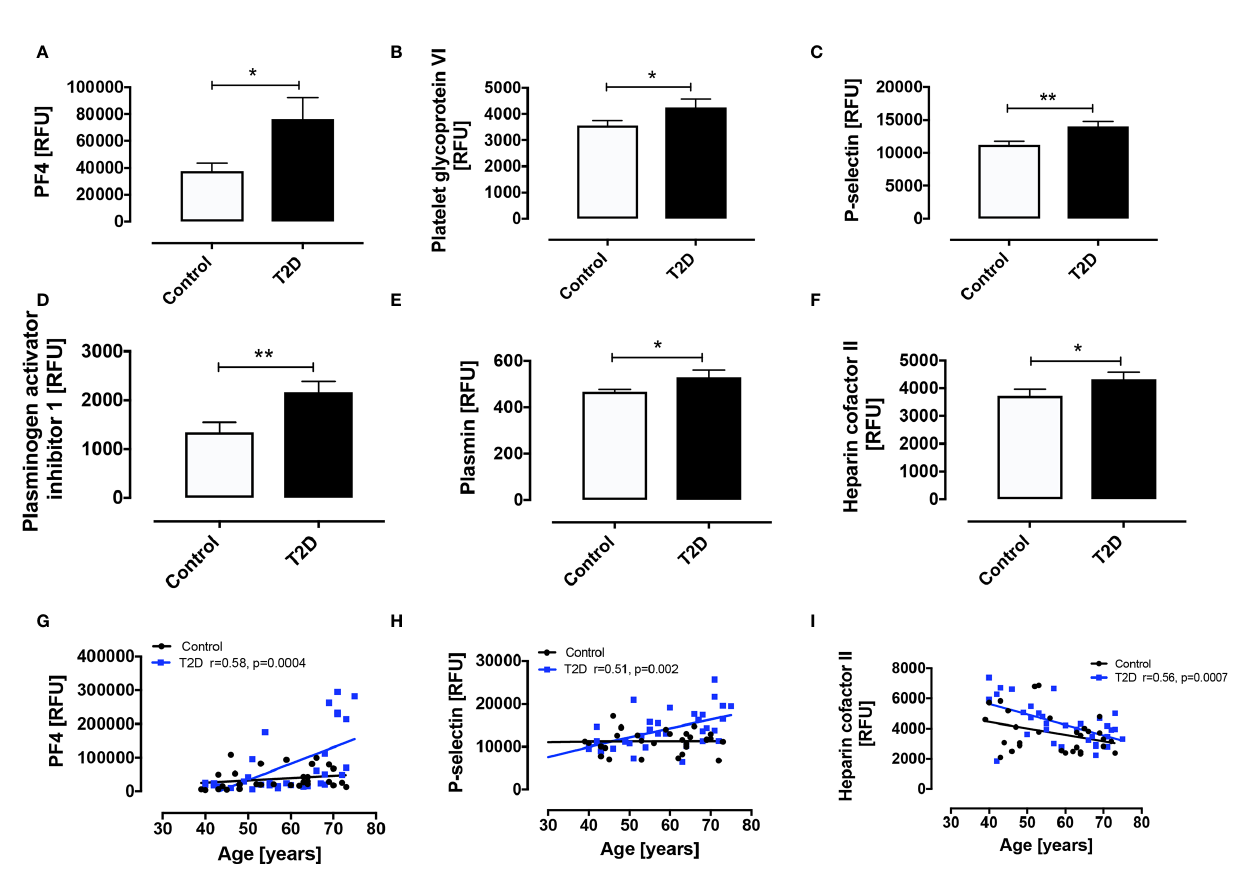
FIGURE 1 | Circulatory levels of platelet related proteins in obese type 2 diabetes (OT2D) and control subjects. Plasma protein levels of platelet factor 4 (PF4) (A) , platelet glycoprotein VI (PGVI) (B) , P-selectin (C) , plasminogen activator inhibitor I (PAI-1) (D) , plasmin (E) , plasmin and heparin cofactor II (F) . Age correlated with levels of PF4 (r = 0.58) (G) , P-selectin (r = 0.51) (H) and Heparin cofactor II (r = 0.56) (I) in the T2D cohort only. RFU: relative fl uorescent units; *p < 0.05; **p <